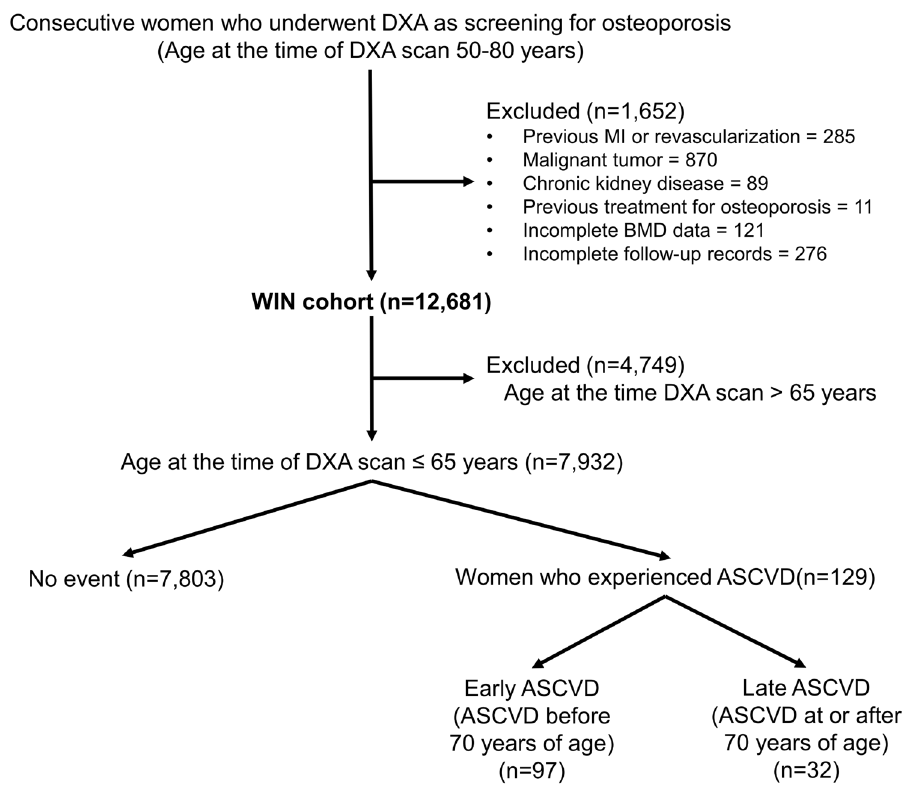
Figure 1. Study flow. From the Women Study for the Interaction between Bone and Vascular Health (WIN cohort), a total of 7932 women aged 65 years or lower who underwent DXA as osteoporosis screening were analyzed. Participants were categorized according to the outcome event, where 129 women experienced ASCVD. Women with ASCVD were further stratified based on the age at the event as early (< 70 years) and late ASCVD (≥ 70 years). ASCVD atherosclerotic cardiovascular disease, BMD bone mineral density, DXA dual- energy X-ray absorptiometry, MI myocardial